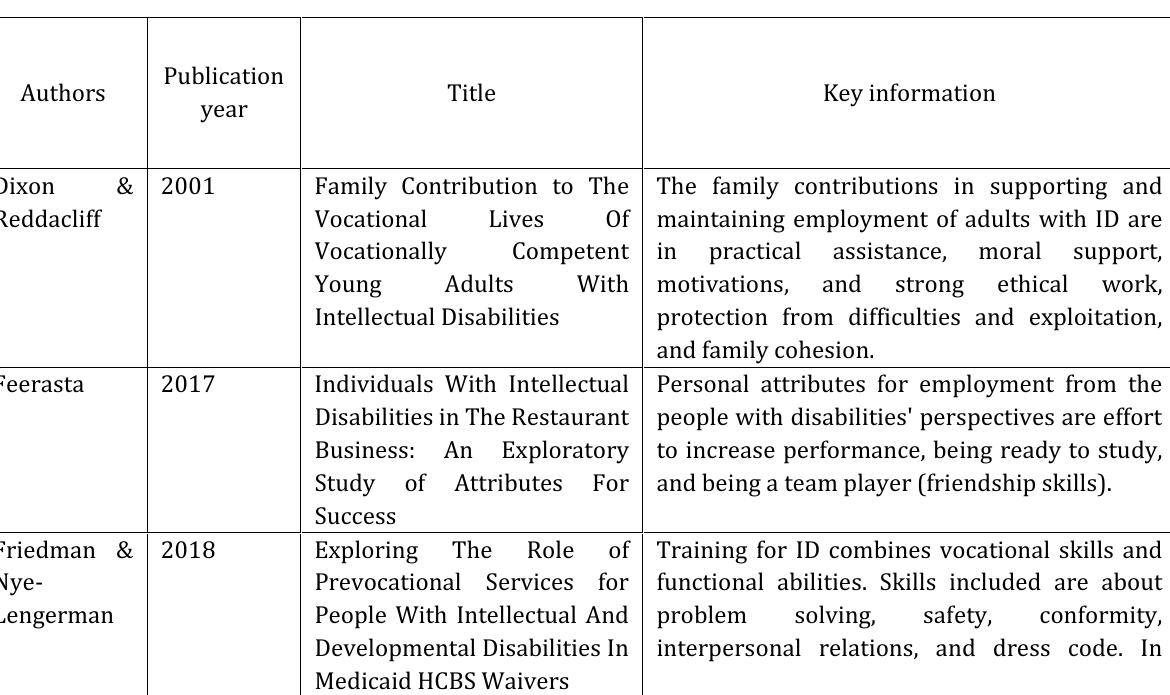
Fig 1 The search strategy's flow diagram Table 1 Results found based on the search